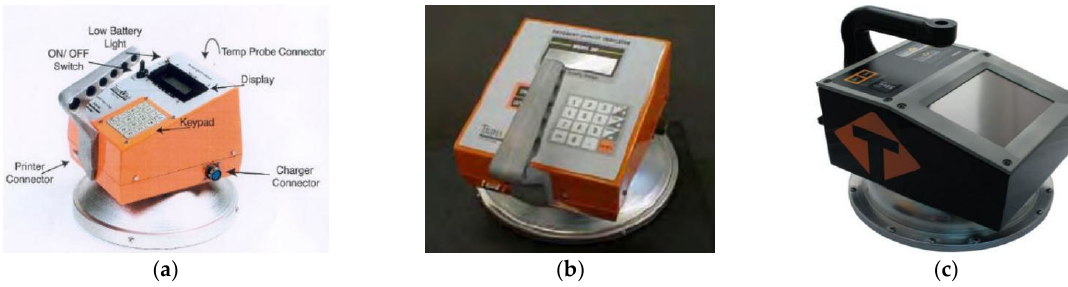
Figure 2. The commonly used PQI instruments: ( a ) PQI 300; ( b ) PQI 310; ( c ) PQI 380.